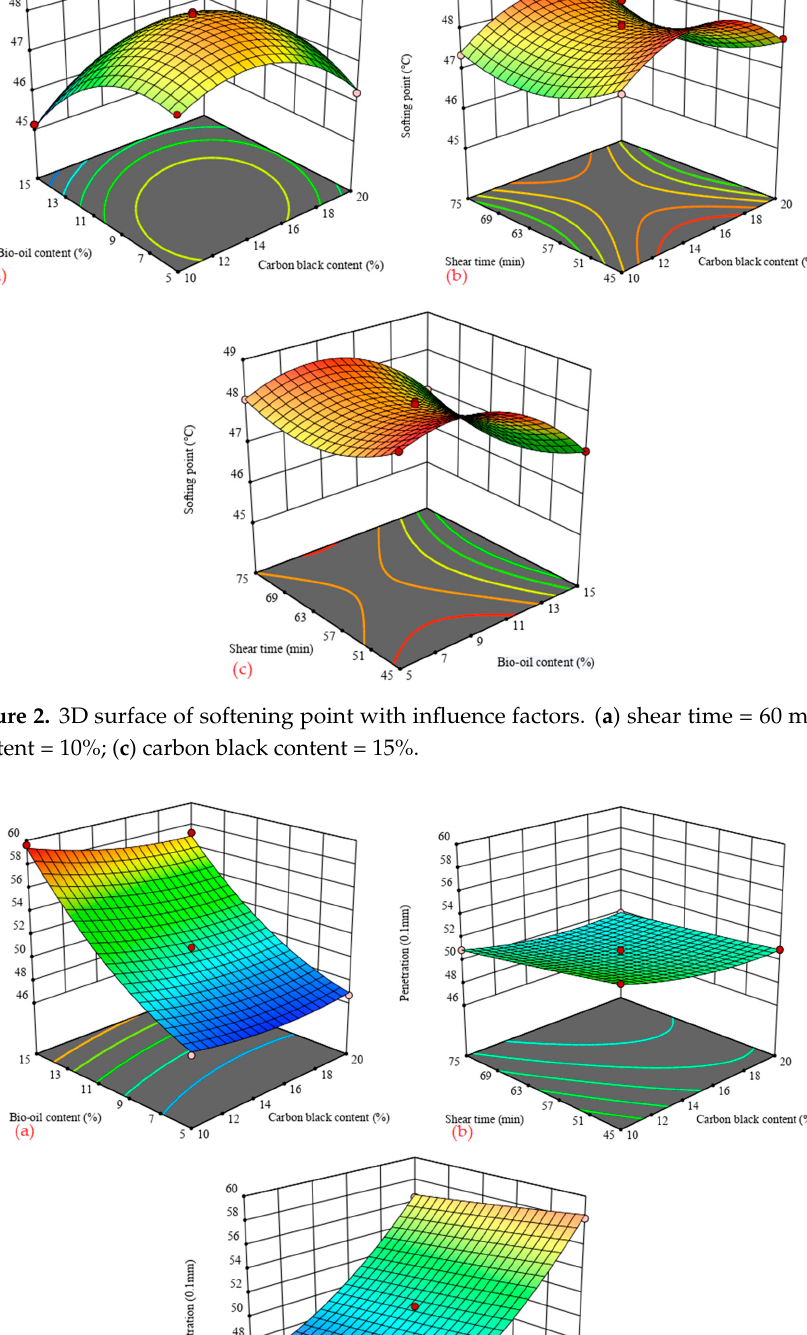
Table 6. MSCR test results.